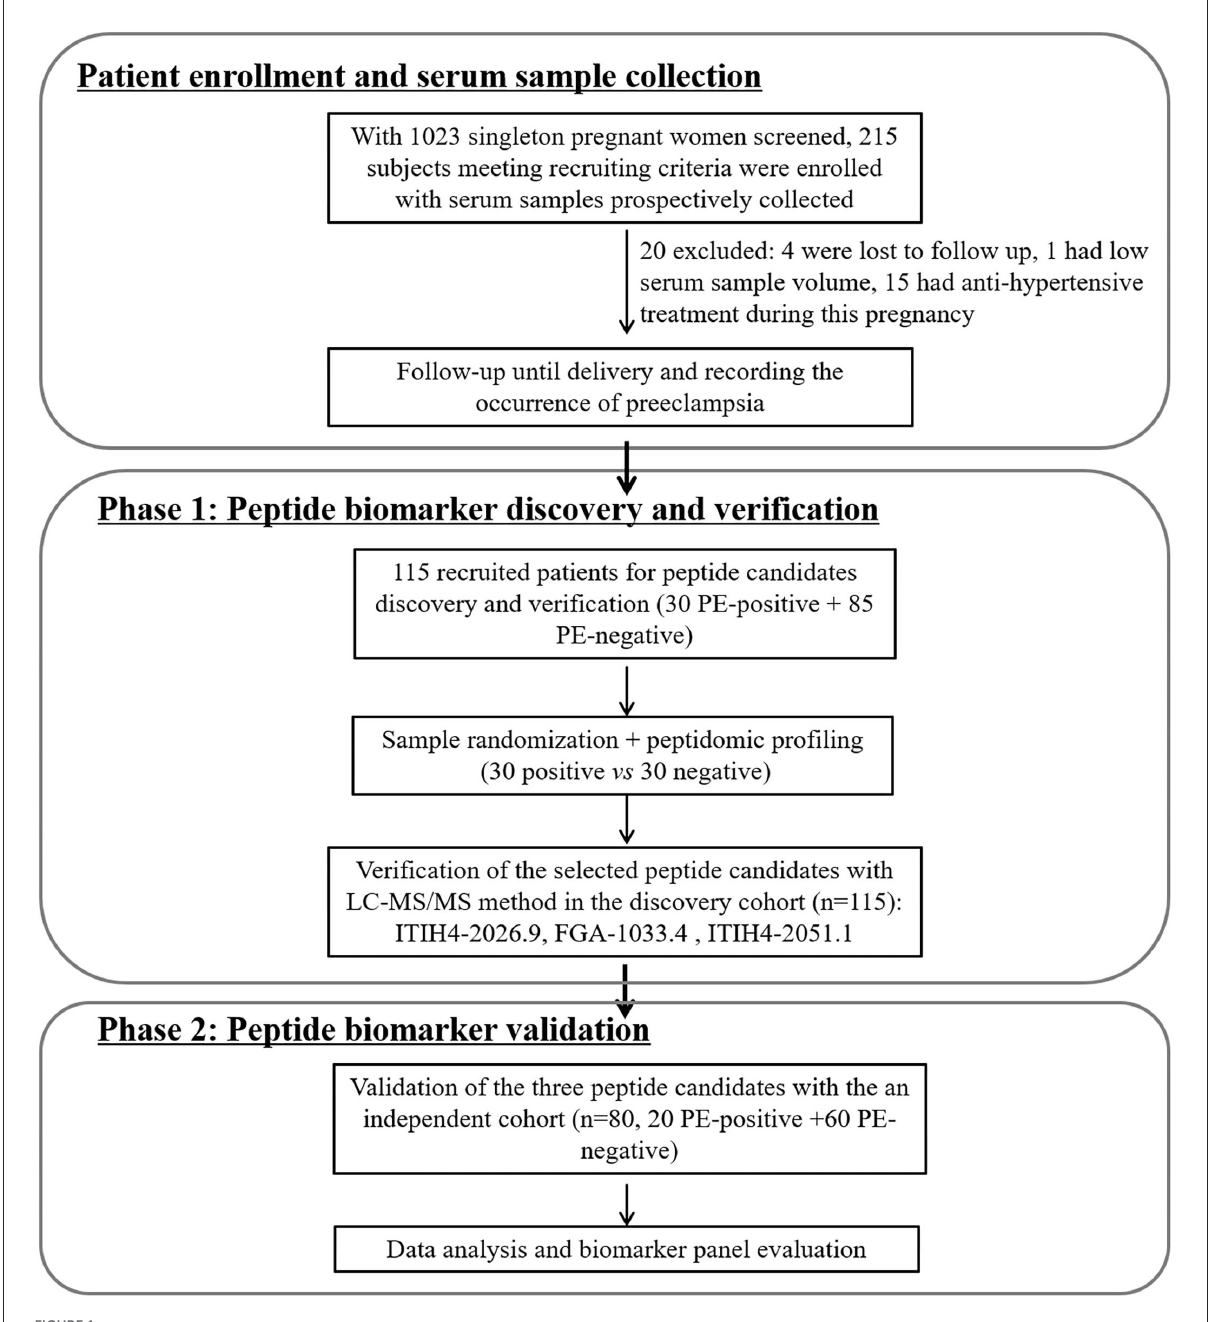
FIGURE1 Schematic diagram for patient enrollment and peptide biomarker candidates discovery and validation for preeclampsia prediction.